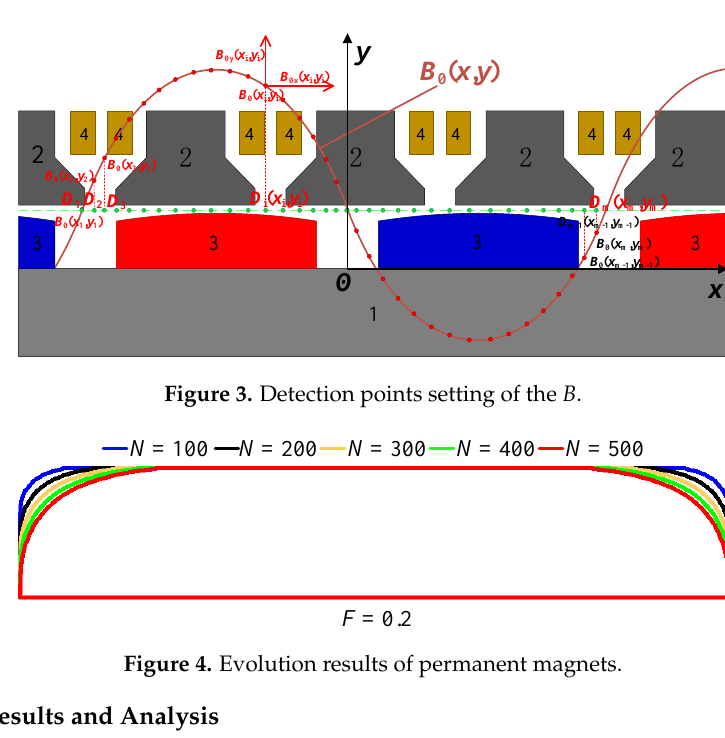
Figure 5. Flux density without optimization. Figure 6. FFT decomposition of flux density without optimization. The optimization results for CPLMG are shown in Figure 7 and its FFT decomposition with level-set optimization is shown in Figure 8. The related THD of the harmonic content is lower than FFT analysis